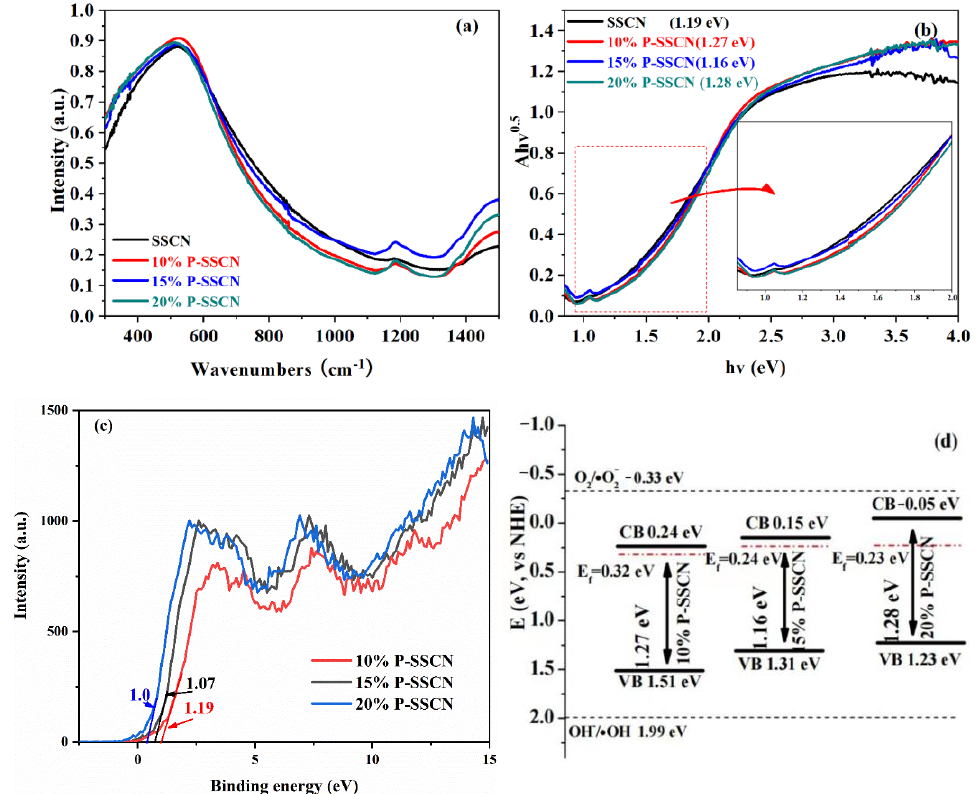
Figure 6. ( a ) UV – vis DRS spectra, ( b ) (Ahν)^0.5 vs. hν curves of SSCN, 10% P -SSCN, 15% P-SSCN, and 20% P-SSCN, ( c ) XPS valence band spectrum, ( d ) Band structures of 10%P-SSCN, 15%P-SSCN, and 20%P-SSCN.